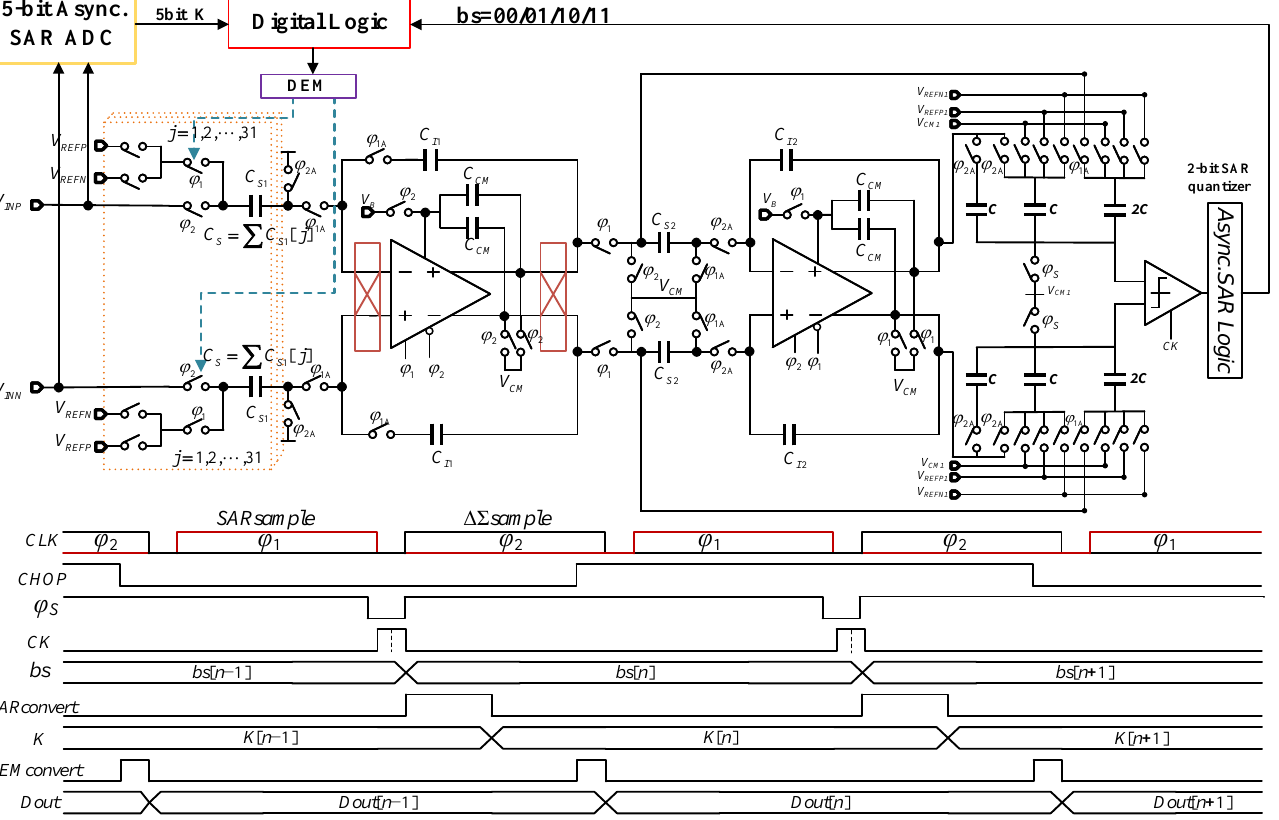
Figure 6. Simplified circuit diagram of the proposed zoom ADC and the corresponding timing diagram. The ∆Σ ADC tracks the input signal during the ϕ 2 phase while the first-stage integrator is chopped to suppress the first-stage amplifier’s offset and 1